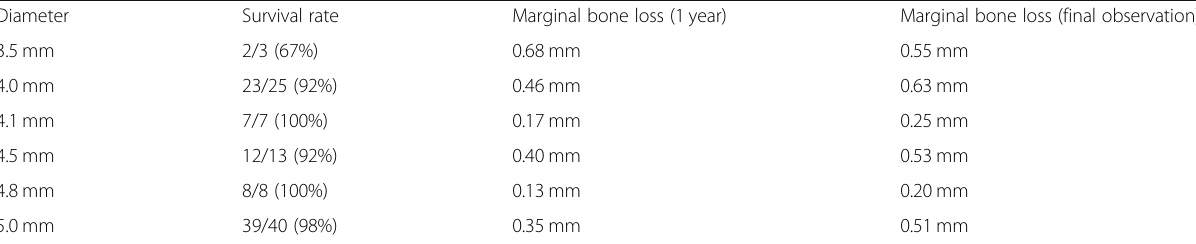
Table 6 Survival rate and marginal bone loss according to fixture diameter Diameter